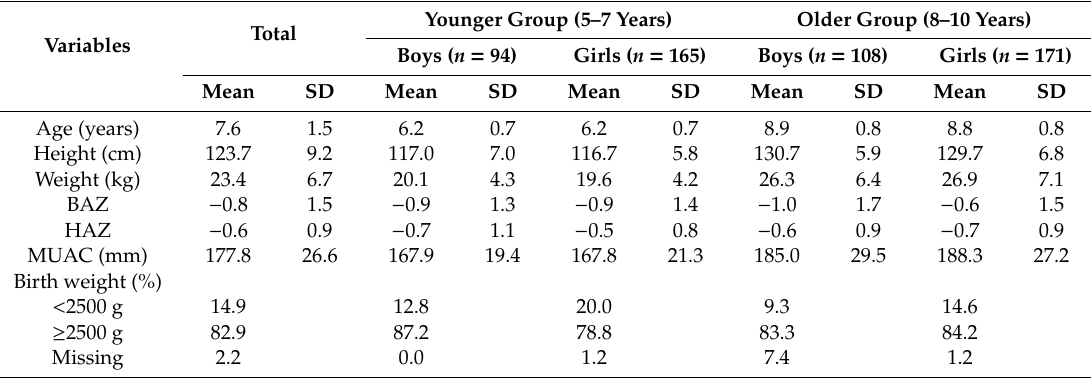
Table 1. Anthropometric characteristics of the study population, according to sex and age group.